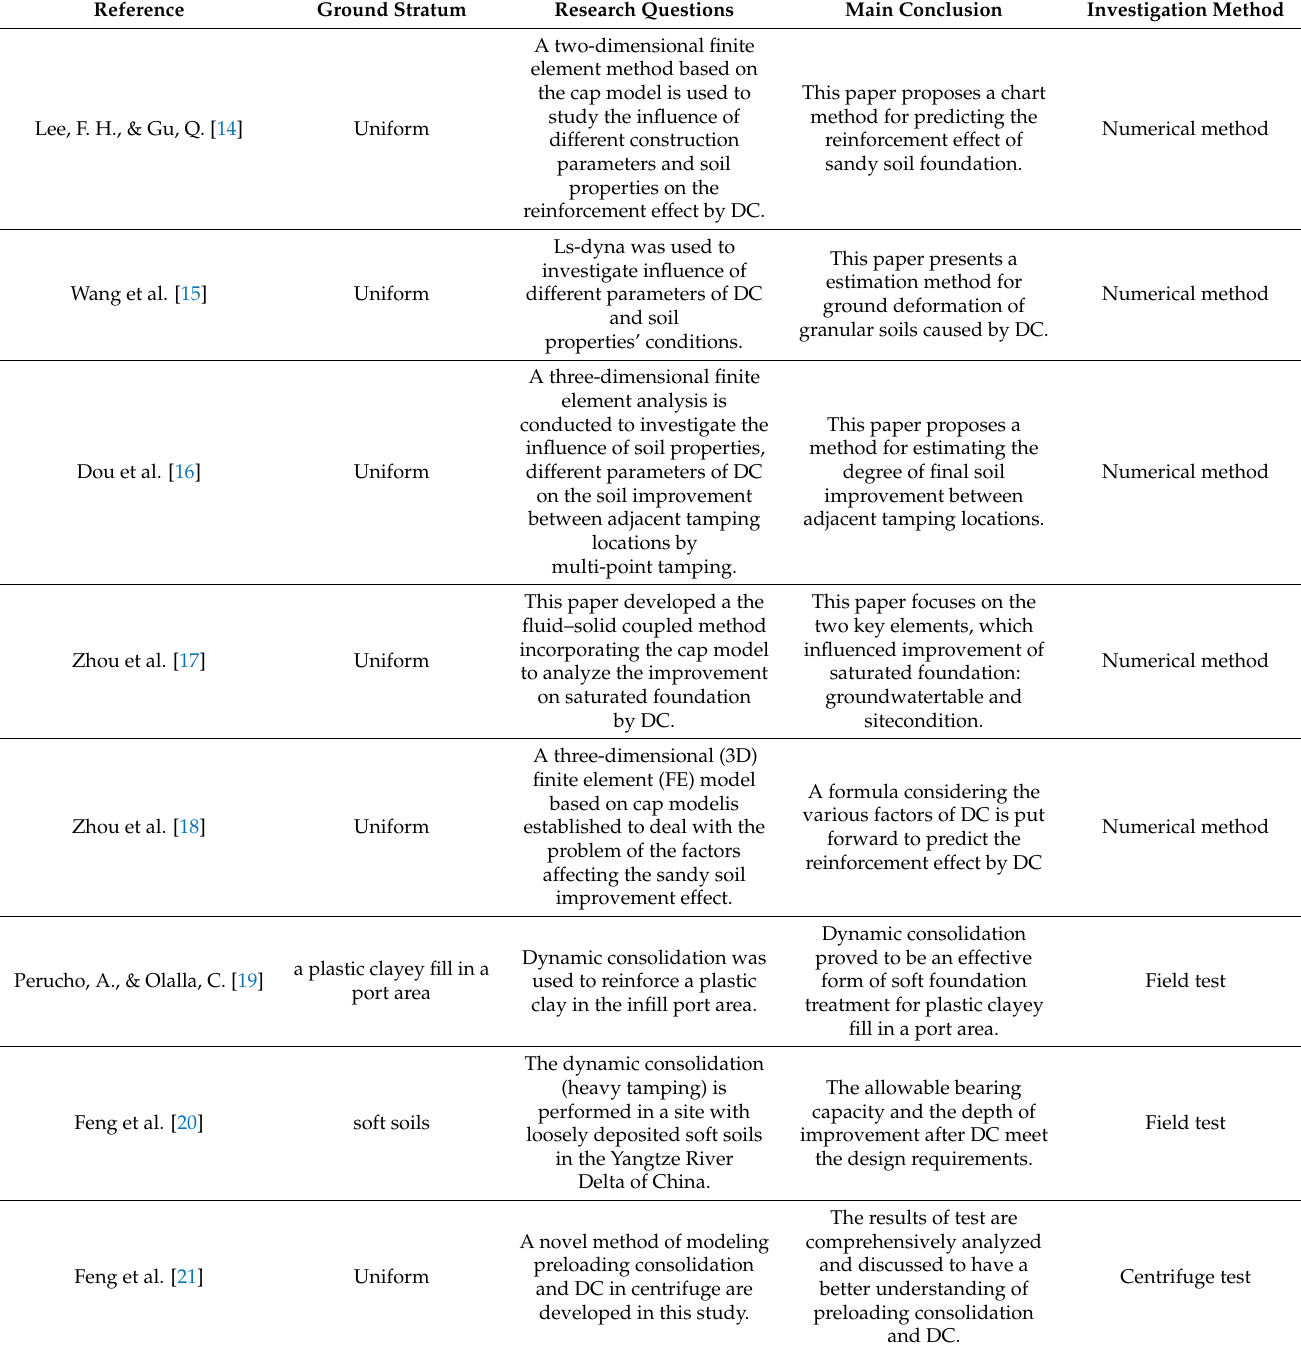
Table 1. Summary of previous research on DC through field tests, numerical simulation, and experimental models